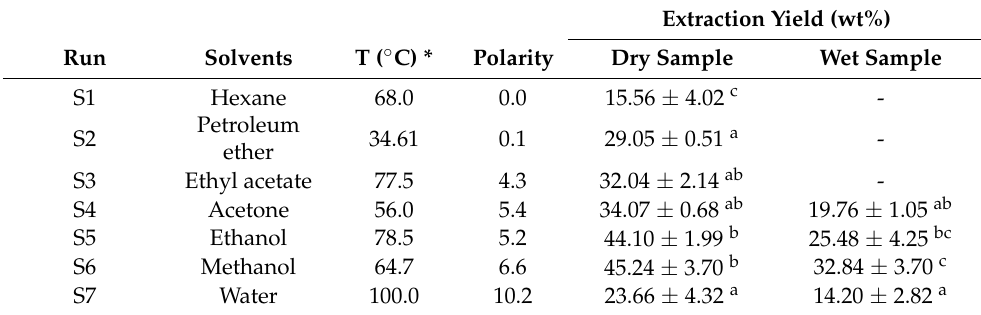
Table 1. Results of the extraction yield (%) using the Soxhlet extraction process for dried and whole (without drying) fermented soybean samples using different solvents. Extraction Yield (wt%) Run Solvents T ( ◦ C) * Polarity Dry Sample Wet Sample S1 Hexane 68.0 0.0 15.56 ± 4.02 c - Petroleum 34.61 0.1 29.05 ± 0.51 a S2 ether S3 Ethyl acetate